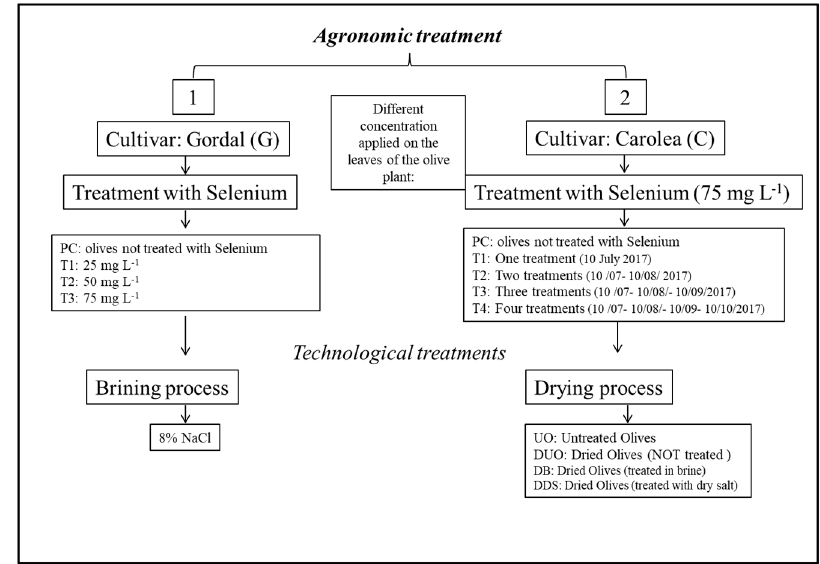
Figure 1. A schematic overview of the experimental plan .